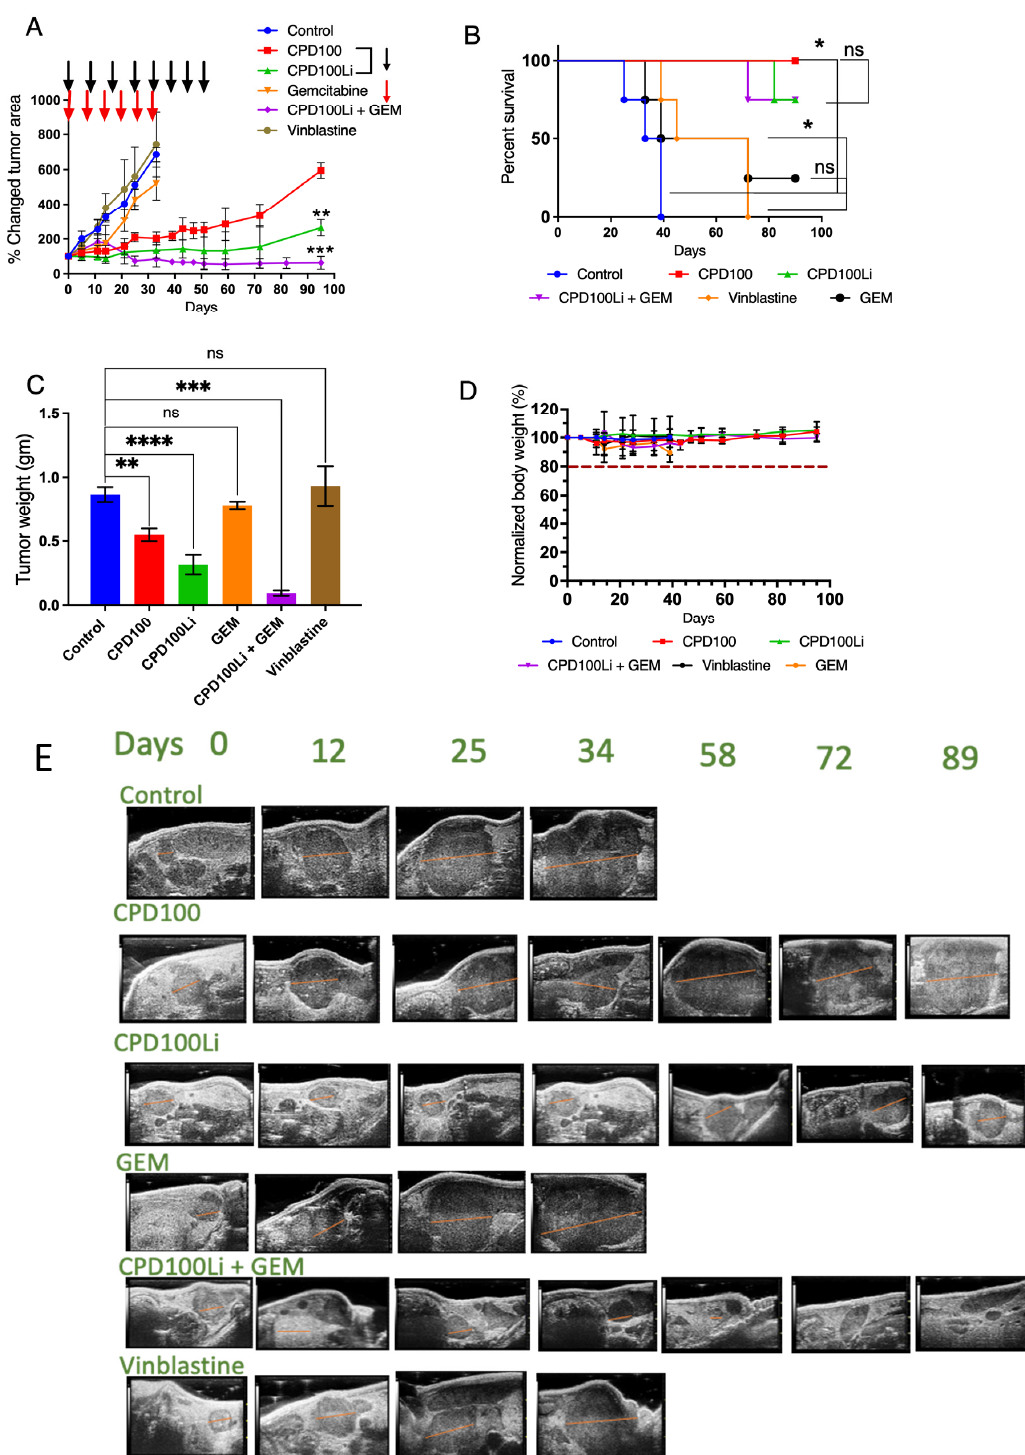
Figure 4. In vivo efficacy of CPD100 and CPD100Li in the Panc-1 tumor model. In vivo efficacy of CPD100, CPD100Li, GEM, CPD100Li + GEM, and vinblastine in PANC-1 orthotopic tumor ( A ), survival curve ( B ), tumor weight post-treatment ( C ), normalized body-weight of mice as a function of days ( D ), representative tumor ultrasound images for the treatment groups; tumor areas were calculated in 3D B-Mode of Vevo 2100 ( E ). ns ( p > 0.05), * ( p ≤ 0.05), ** ( p ≤ 0.01), *** ( p ≤ 0.001), and **** ( p ≤ 0.0001) represents statistical significance compared to the control group by one-way ANOVA.